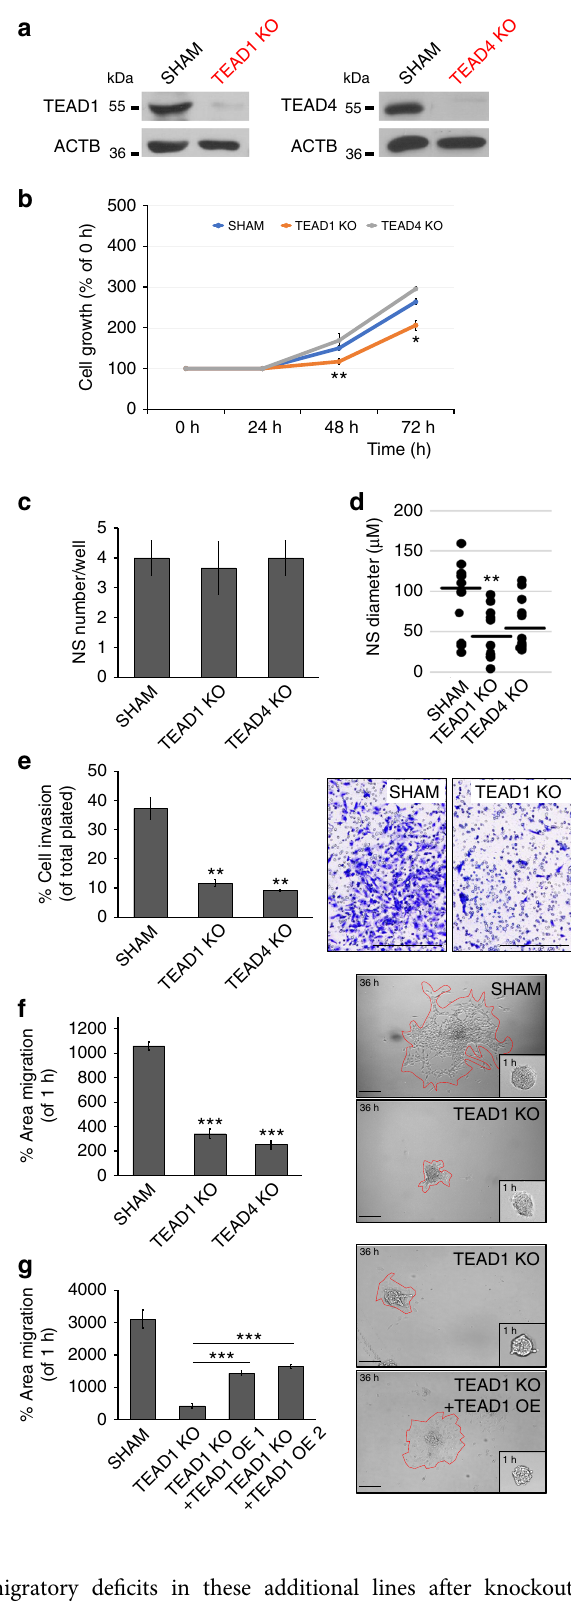
migratory de fi cits in these additional lines after knockout of TEAD1 or TEAD4 (Supplementary Fig. 5e – f). Finally, to test if TEAD1 activity is regulating cell migration directly, we over- expressed TEAD1 in TEAD1KO cells and assessed their spheroid migration behavior. TEAD1 overexpression rescued migration de fi cits in TEAD1KO spheroids by ~50% (Fig. 3g, Supplementary